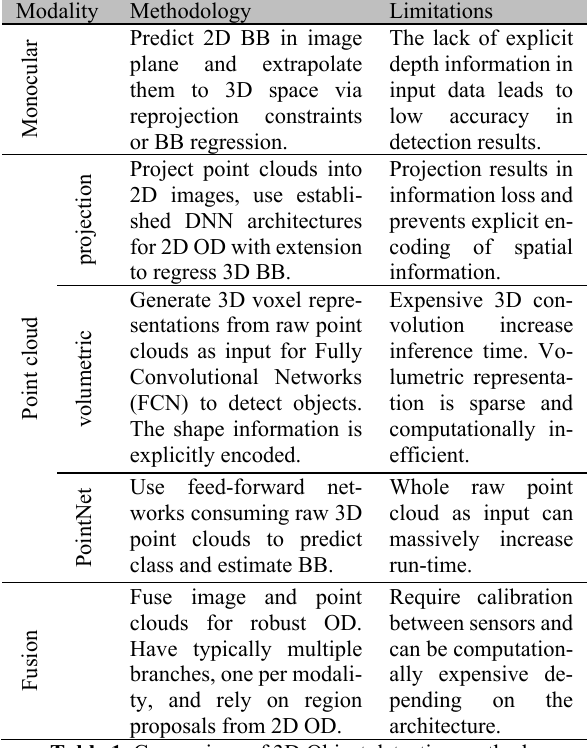
Table 1 . Comparison of 3D Object detection